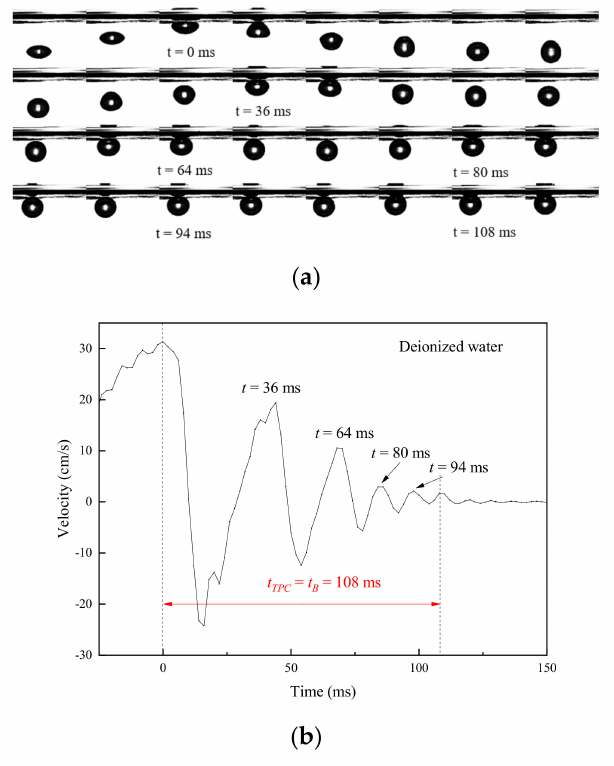
Figure 10. Collision-rebound process ( a ) and velocity variation ( b ) of the bubble with talc surface in deionized